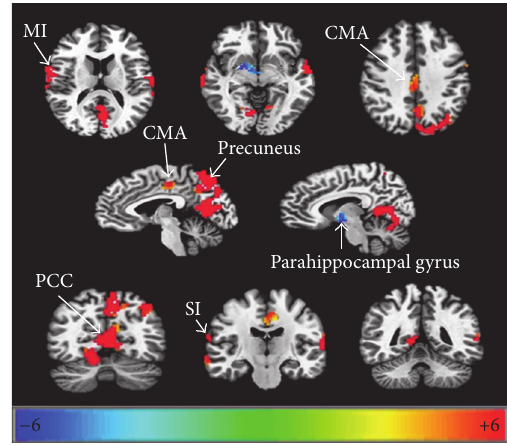
Figure 2: Cortical reorganization in the areas of palsy recovered group compared to healthy control group when conducting finger movements. 𝑃 = 0.05 , 𝛼 < 0.05 , corrected with Monte-Carlo method. PCC: posterior cingulate cortex; MI, primary motor cortex; SI: primary somatosensory cortex; CMA: cingulate motor area.